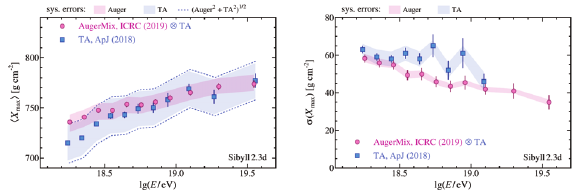
Figure 3. Comparison of (cid:3) X max (cid:4) (left) and σ ( X max ) (right) be- tween measured TA data distributions (blue squares) and the Auger ⊗ TA results (red circles) using Sibyll 2.3d.